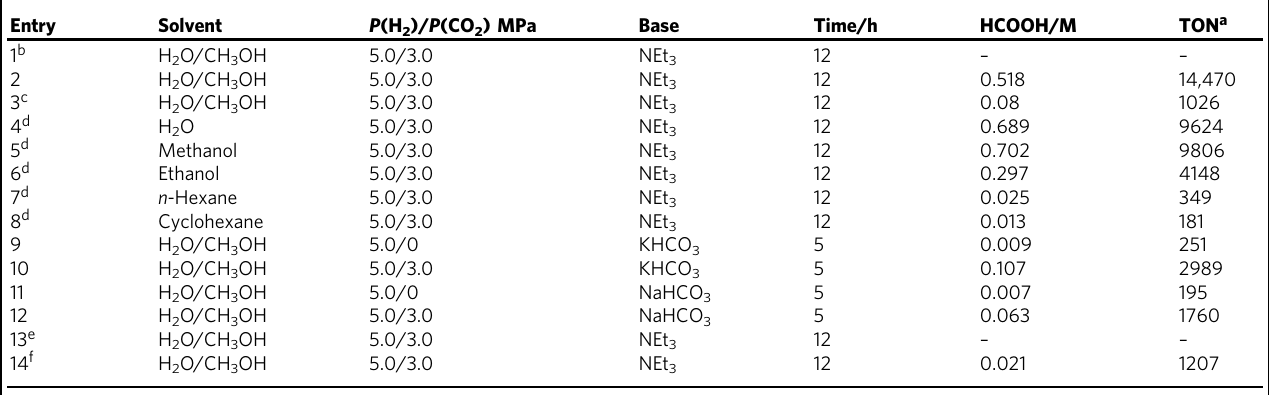
Table 2 Catalytic performance of the gold nanocatalysts for CO 2